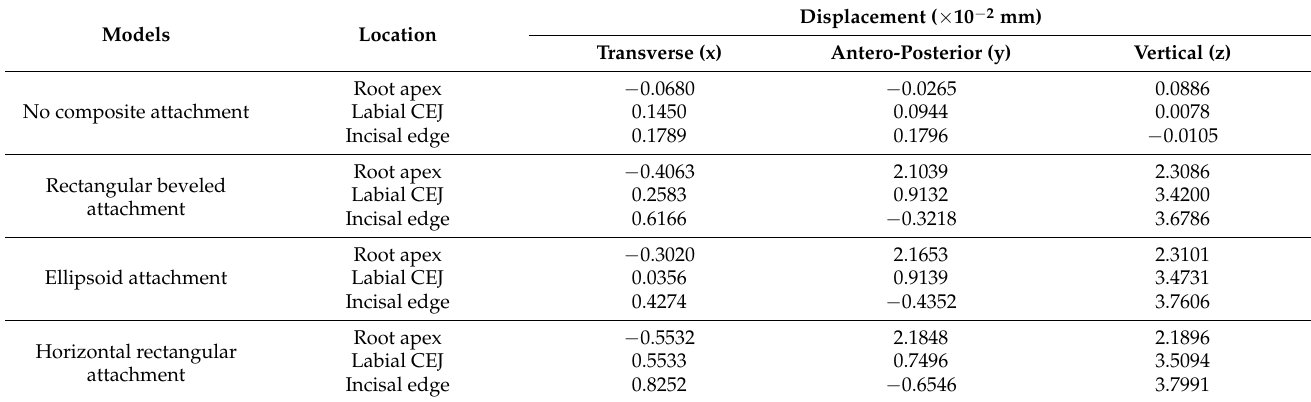
Table 2. Nodal displacement of the upper right central incisor. Transverse direction (x) represents mesial (+) and distal ( − ) movement. Antero-posterior direction (y) represents labial (+) and palatal ( − ) movement. Vertical direction (z) represents extrusion (+) and intrusion ( − ) movement.